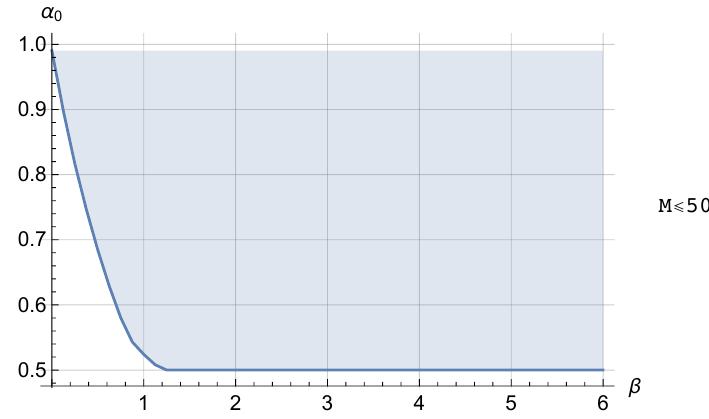
Figure 6 . Same as the previous (cid:12)gure projected on the ( (cid:12); (cid:11) 0 )